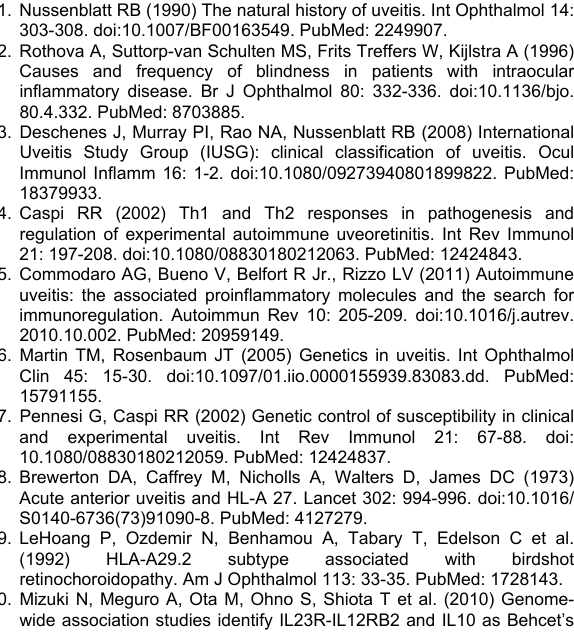
Table S2. Statistical power of the comparison between uveitis patients without macular edema and controls for each analyzed IRF5 genetic variants at the 5% significance